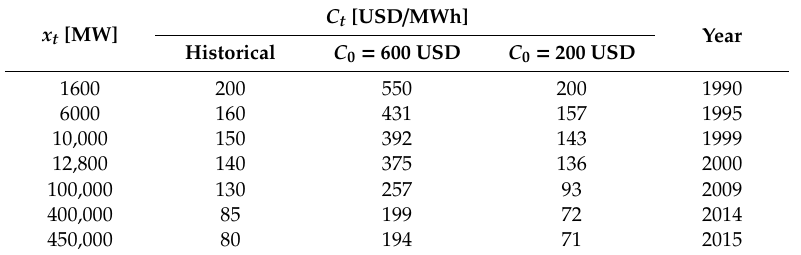
Table 4. Comparison of historical and calculated data for wind power. Own work based on [54,55].